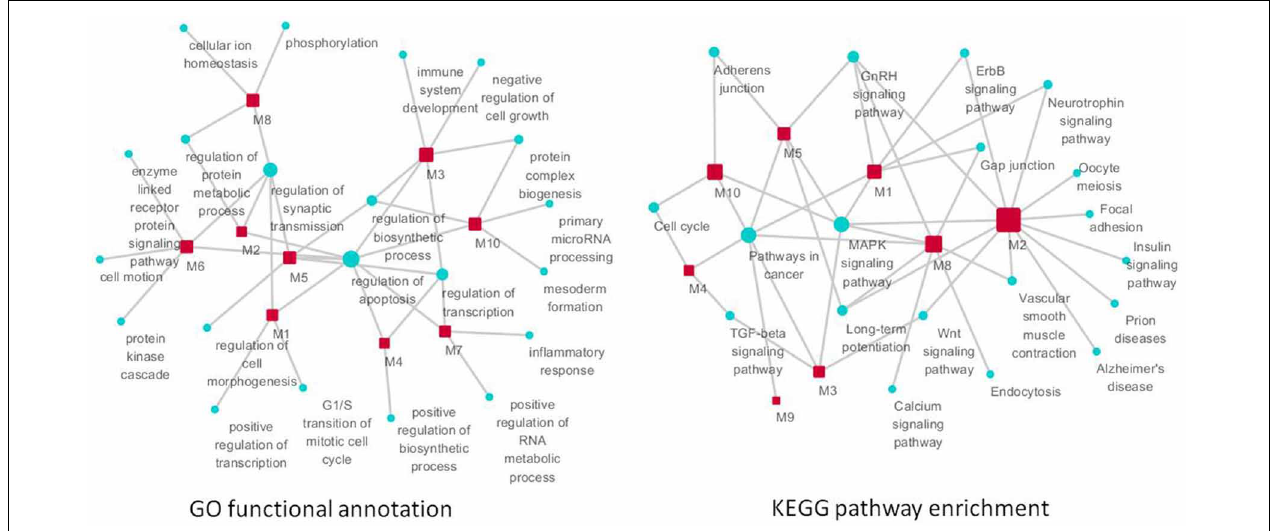
FIGURE 7 | The function of significant modules and nodes of genetic sub-network in the brain of SAMP8 mice. GO functional annotation ( left ) and KEGG pathway enrichment ( right ) of 10 modules. Red